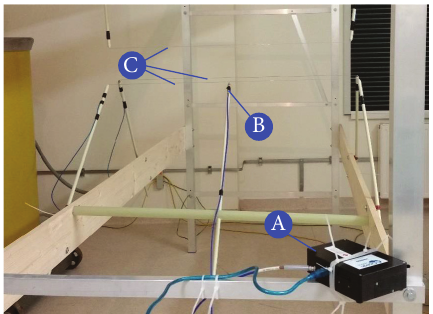
Figure 2: View of the fi bre optic cable head used for the measurement of emission spectra generated by corona